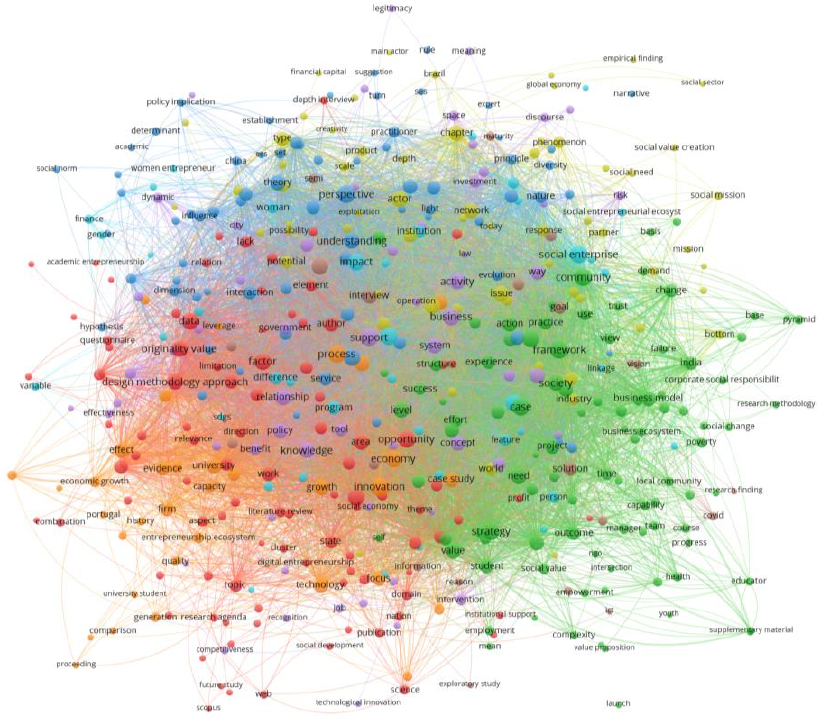
Figure 4. Semantic network. Source: authors based on VOSviewer software.